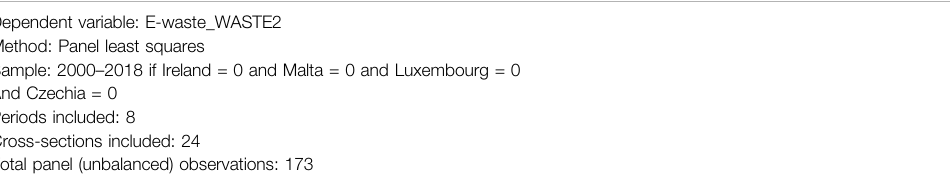
TABLE 7 | Introducing the Internet variable into the model / Source: Own calculation using EViews 11. Dependent variable: E-waste_WASTE2 Method: Panel least squares Sample: 2000 – 2018 if Ireland = 0 and Malta = 0 and Luxembourg = 0 And Czechia = 0 Periods included: 8 Cross-sections included: 24 Total panel (unbalanced) observations: